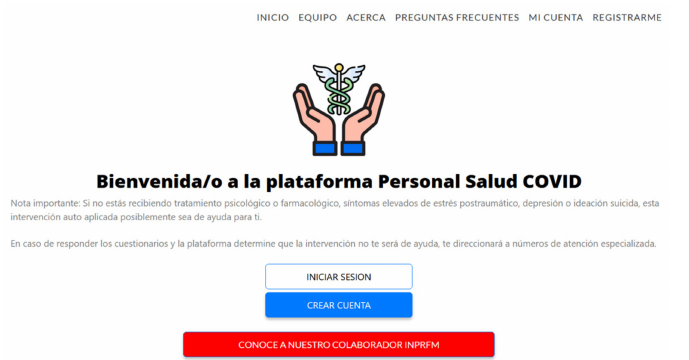
Figure 4. Main page of the Personal COVID Intervention where the participants need to log in (“iniciar sesion”) or create an account (“crear